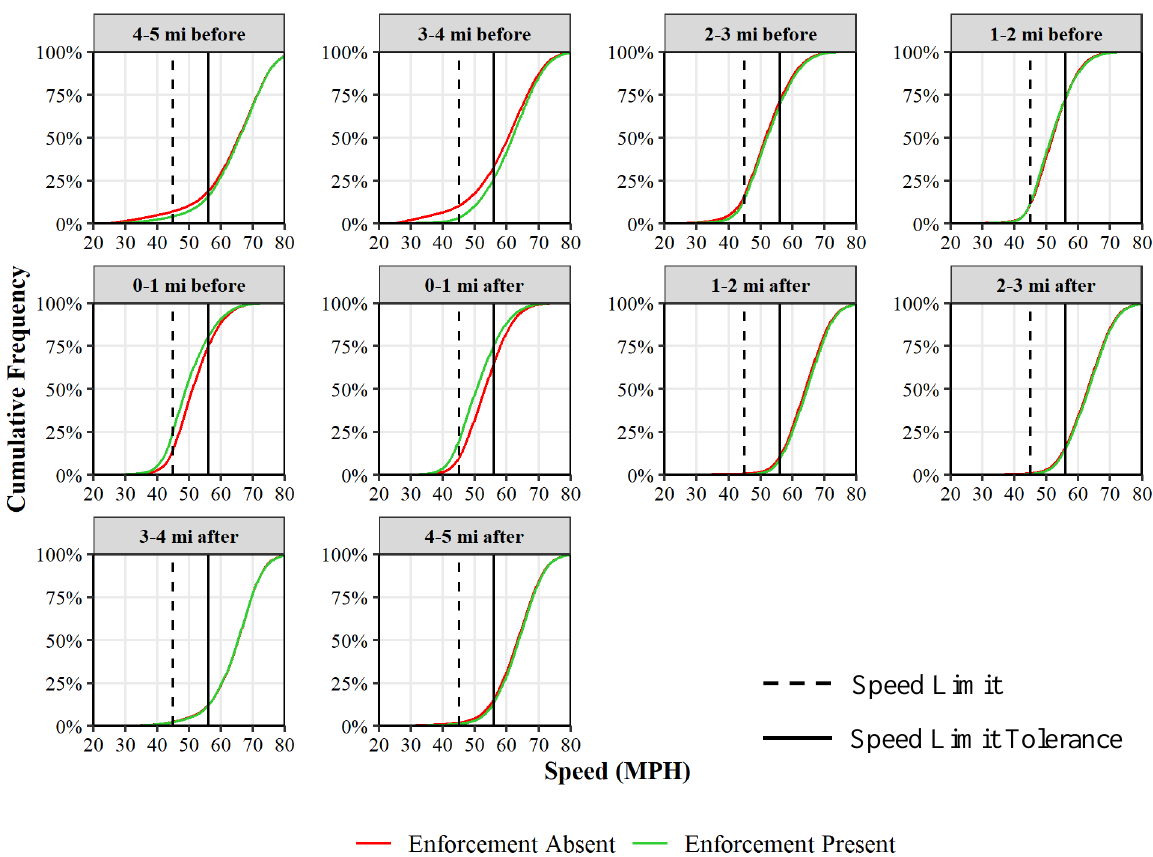
Figure 6. Speed compliance with respect to enforcement location on I-79 S work zone.